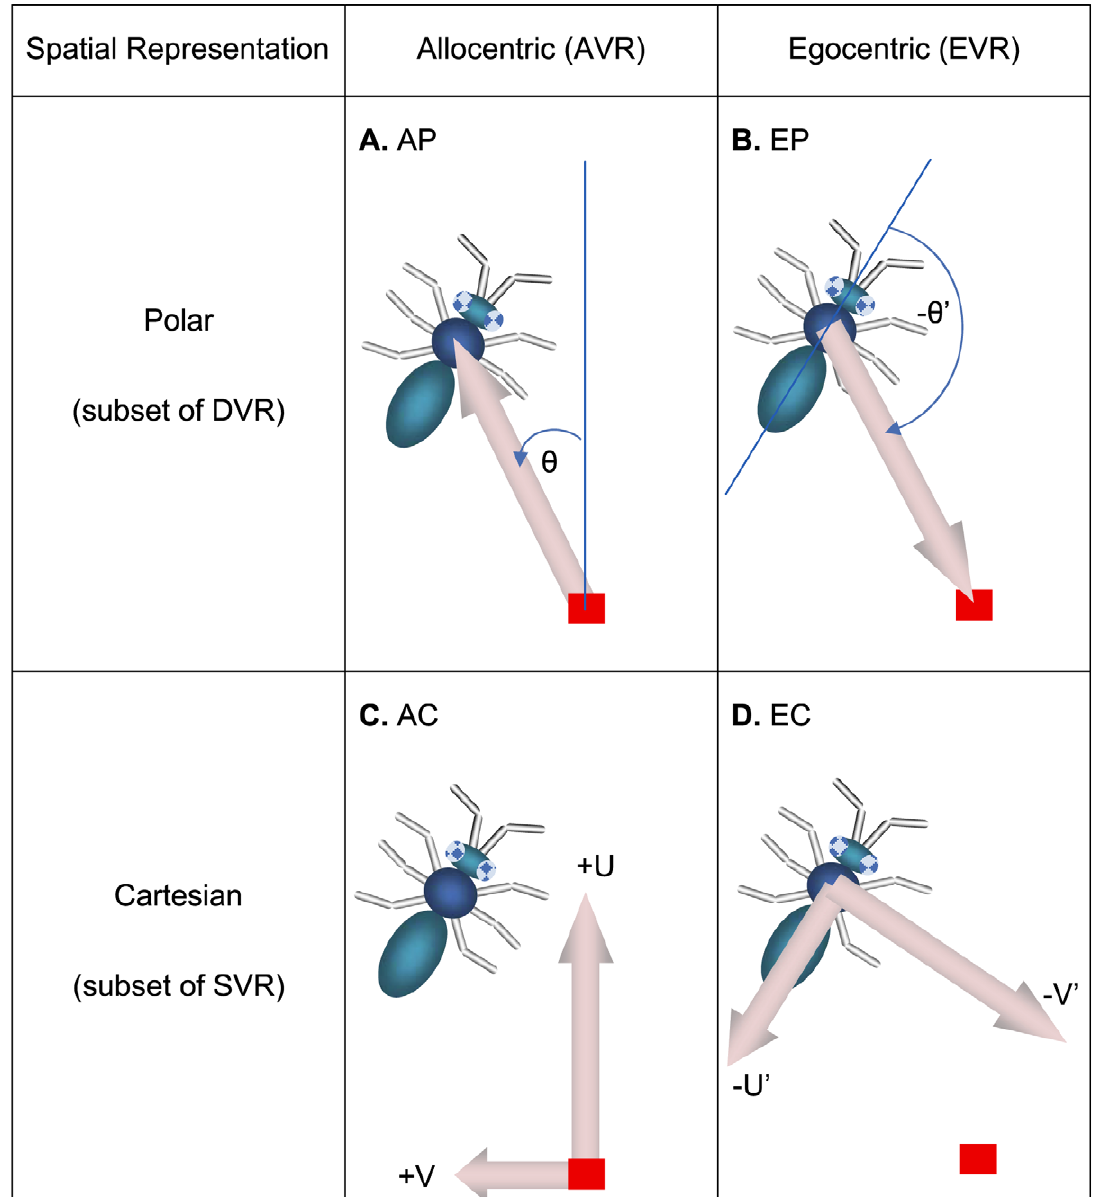
Figure 2. Examples from 4 extended classes of neural representations of 2-D Euclidean space. ( A ) An allocentric polar (AP) representation as an example of an allocentric dynamic vectorial representation (ADVR). ( B ) An egocentric polar (EP) representation as an example of an egocentric dynamic vectorial representation (EDVR). ( C ) An allocentric Cartesian (AC) representation as an example of an allocentric static vectorial representation (ASVR). ( D ) An egocentric Cartesian (EC) representation as an example of an egocentric static vectorial representation (ESVR). In representational space, the direction of intended motion is denoted + U (analogous to + X of real space - see Fig 1). Similarly, + V is analogous to + Y. By convention, it is assumed that egocentric ‘‘forward’’ is rostral ( + U 9 ), ‘‘backward’’ is caudal, leftward is + V 9 and rightward is 2 V 9 . The thick pink arrows represent distance, thin blue curved arrows represent direction with respect to either an allocentric ( h ) or egocentric ( h 9 ) reference axis (thin blue straight lines). Other diagrammatic conventions are as in Fig. 1.